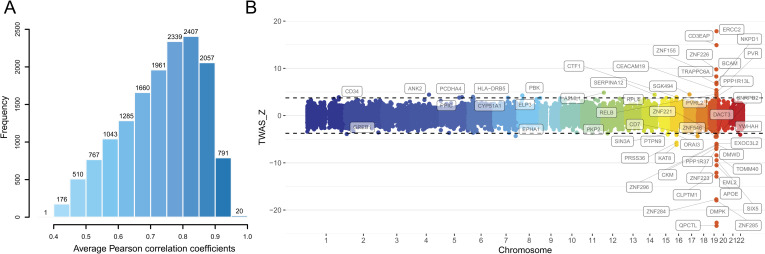
Gene expression prediction models of hippocampal tissue (A) and TWAS results of AD (B). (A) Average Pearson correlation coefficients of 15,017 significant hippocampal gene expression prediction models (pc < 0.05, FWE corrected). (B) Manhattan plot of all TWAS associations of AD in the discovery stage. Each point represents a single gene, with physical position in chromosome plotted on the x-axis and z-score of the association statistics between gene and AD plotted on the y-axis. Transcriptome-wide significant threshold (qc < 0.05, FDR corrected) is highlighted as black dotted lines and the significant associations are labeled with gene names. AD, Alzheimer’s disease; FDR, false discovery rate; FWE, familywise error; TWAS, transcriptome-wide association study.